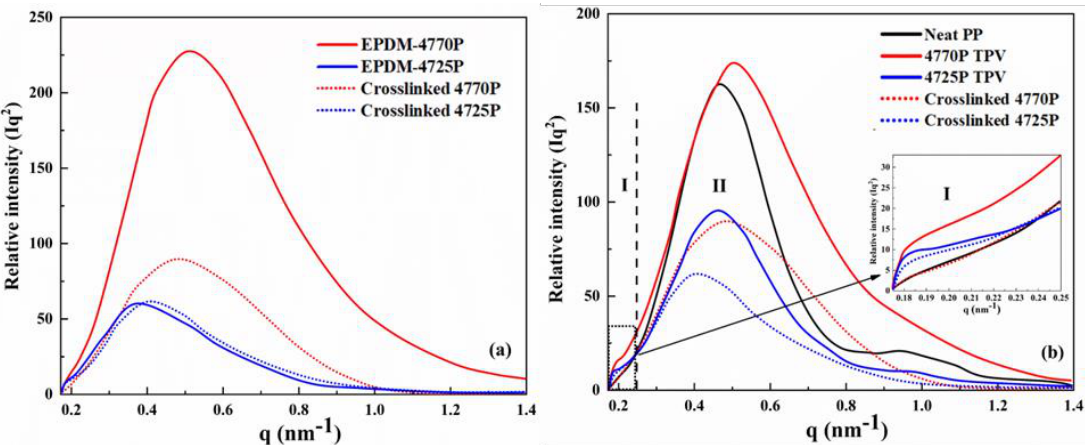
Figure 5. SAXS profiles of the samples: ( a ) The SAXS profiles of EPDMs and crosslinked EPDMs; ( b ) The SAXS profiles of neat PP, EPDM/PP thermoplastic vulcanizates, and crosslinked EPDMs: zone Ⅰ : q ≤ 0.25; zone Ⅱ : q > 0.25.